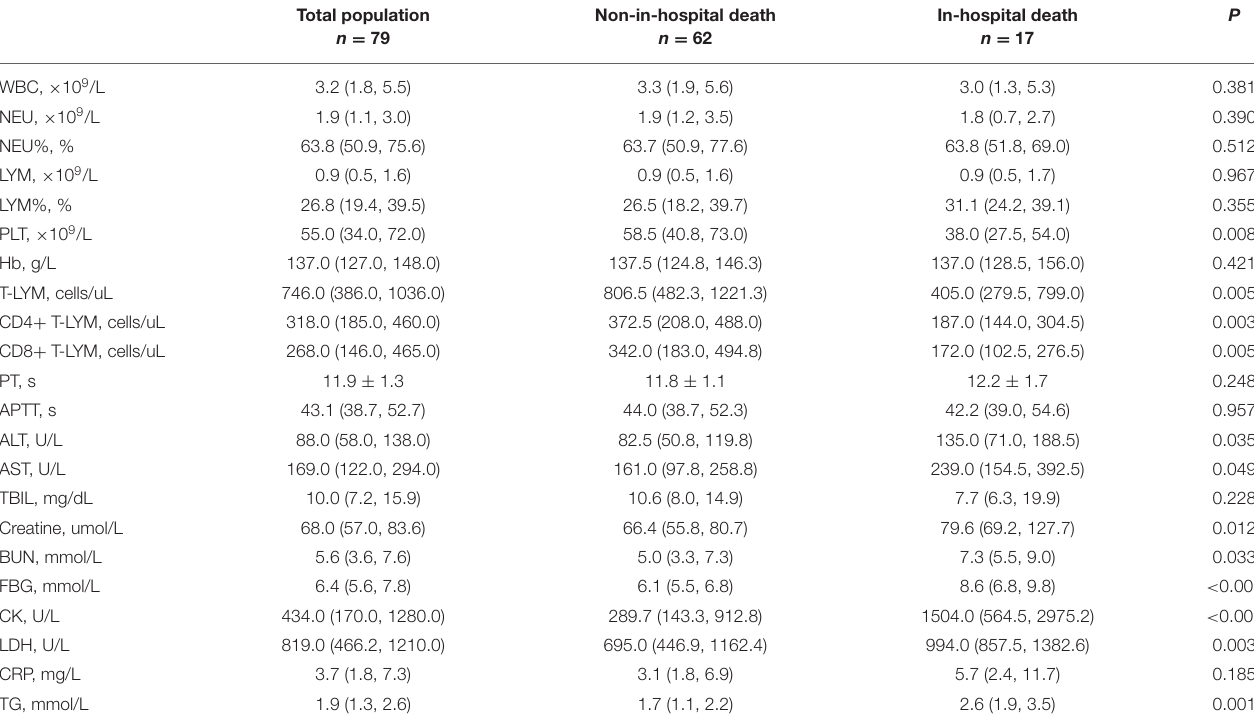
TABLE 3 | Baseline laboratory results of the study